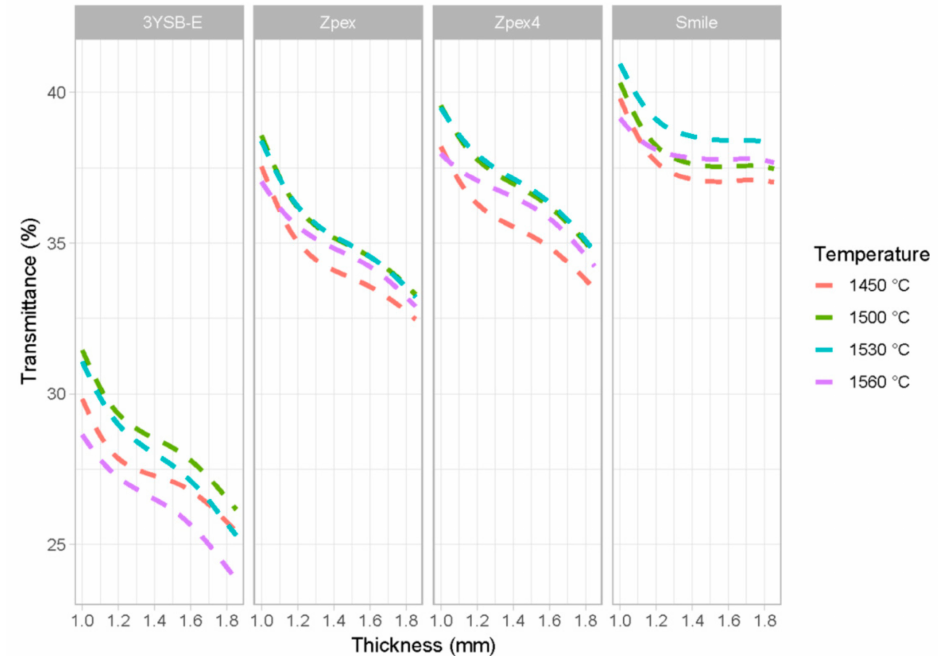
Figure 6. Estimation of transmittance values considering the mean apparent density of the